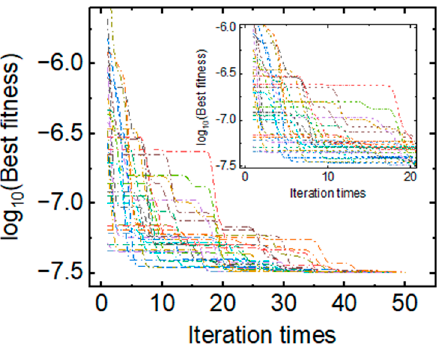
Figure 4. Fitness of the developed optimization design method for ultrasonic